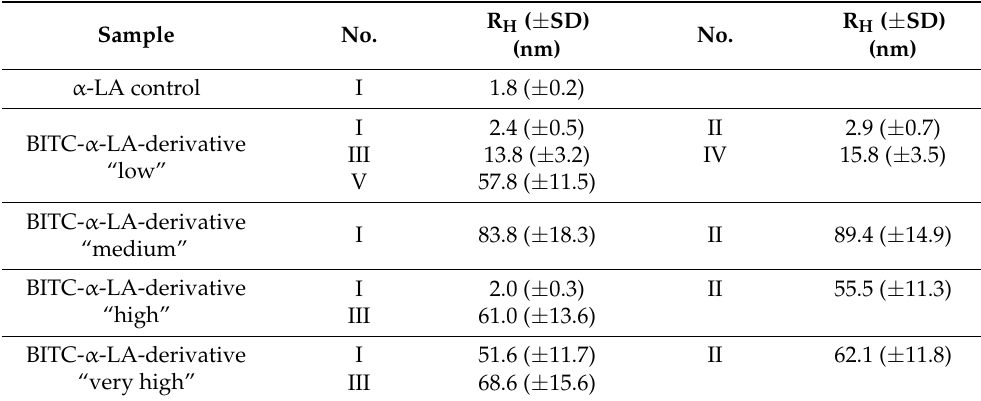
Figure 6. Distribution of hydrodynamic radii of the α -LA control and the BITC- α -LA derivatives. Table 3. Averaged hydrodynamic radii ( R H ) along with standard deviations (SD) of α -LA control and BITC- α -LA derivatives ( n = 20